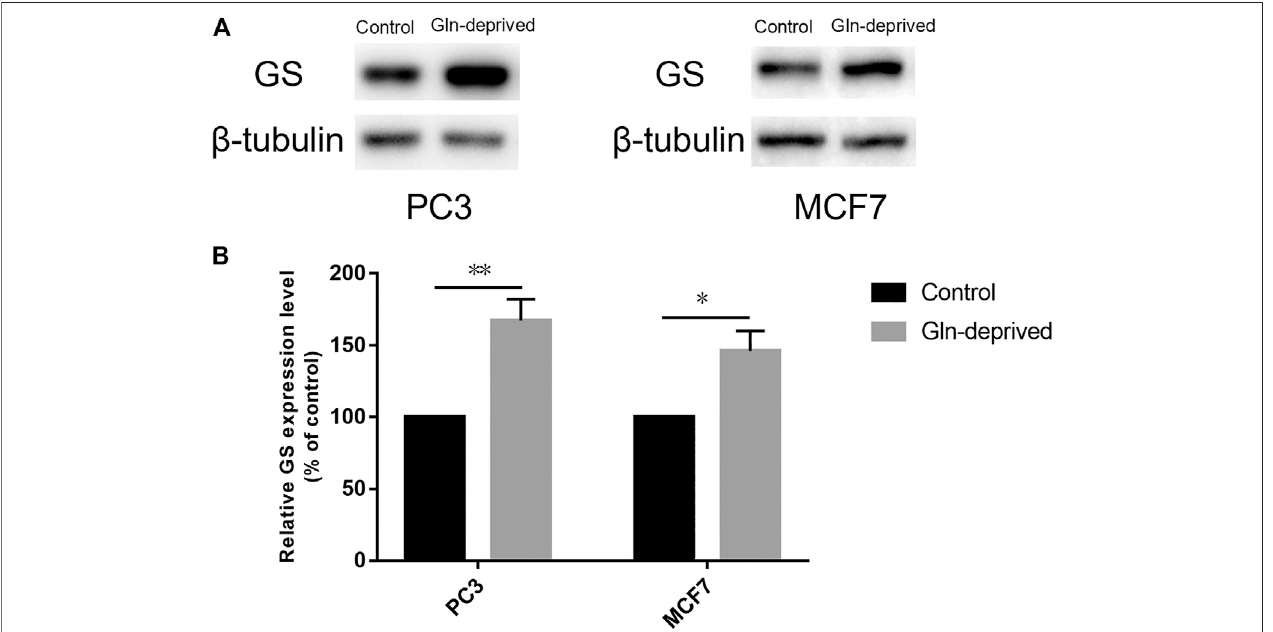
FIGURE 1 | Chronic Gln deprivation augments the levels of GS in MCF7 and PC3 cells. (A) GS protein in cancer cells (MCF7 、 PC3 、 0.06MCF7 、 0.06PC3) analyzed by Western blotting. (B) Relative GS protein contents were evaluated with β -tubulin as a loading control. All data are presented as means ± SEM, * p < 0.05, ** p < 0.01, n (cid:2) 3. GS, glutamine